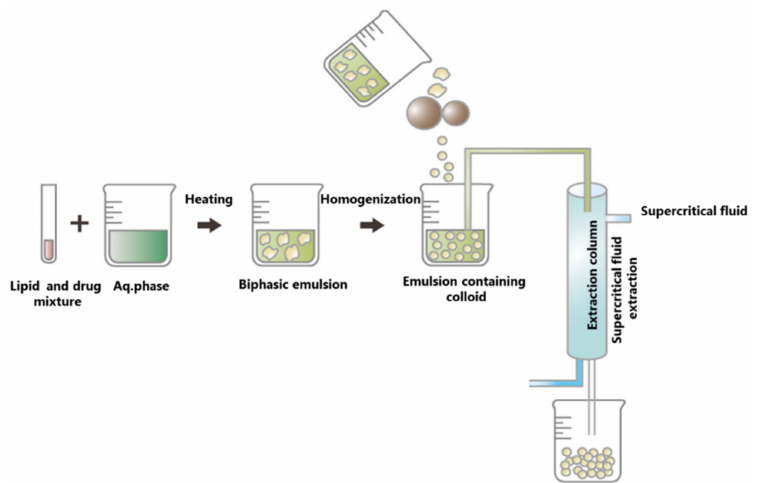
Figure 11. The procedure of supercritical fluid technique.